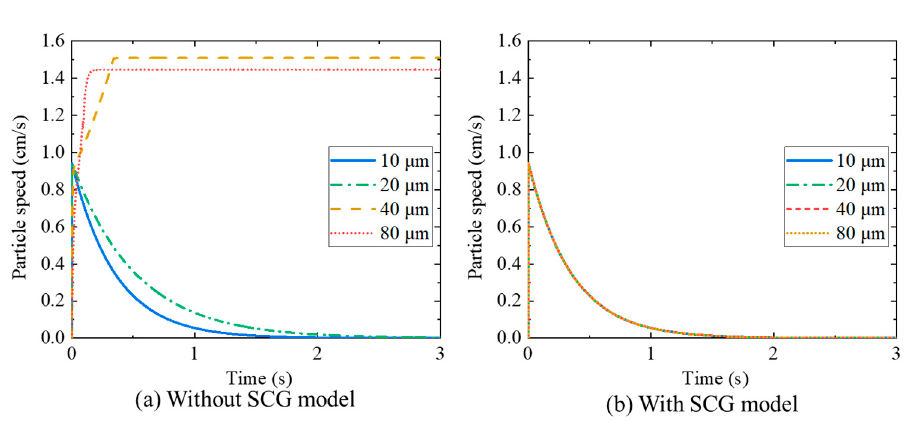
Figure 6. Comparison of the particle speeds in vortex flow field represented by DEM with and without the SCG model.